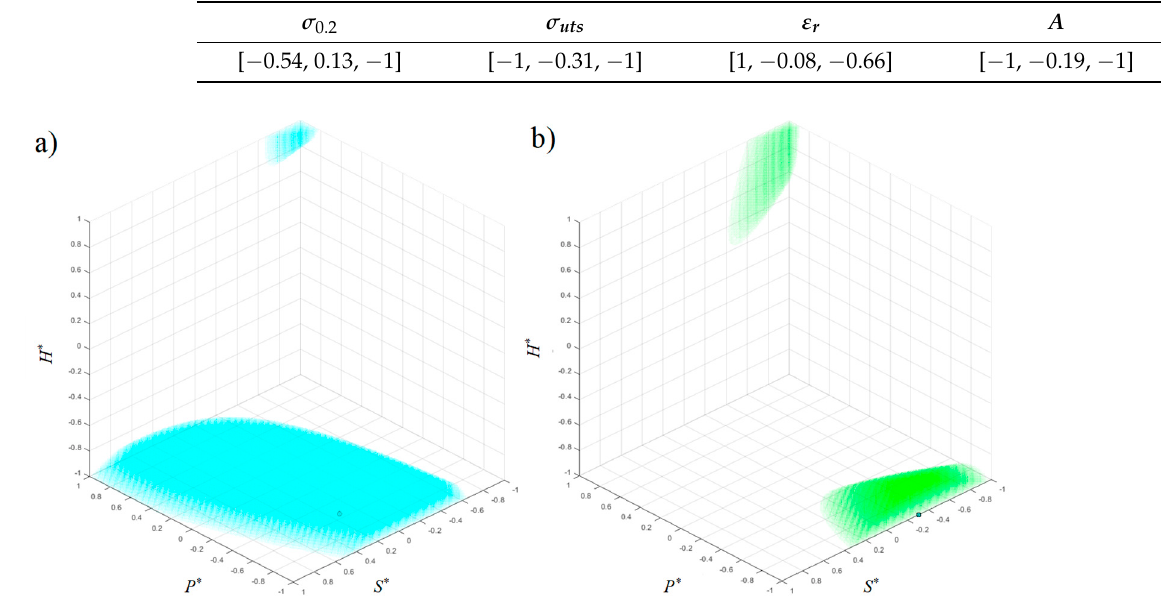
Table 5. Optimal parameters for coded values [ P ∗ max , S ∗ max , H ∗ max ].